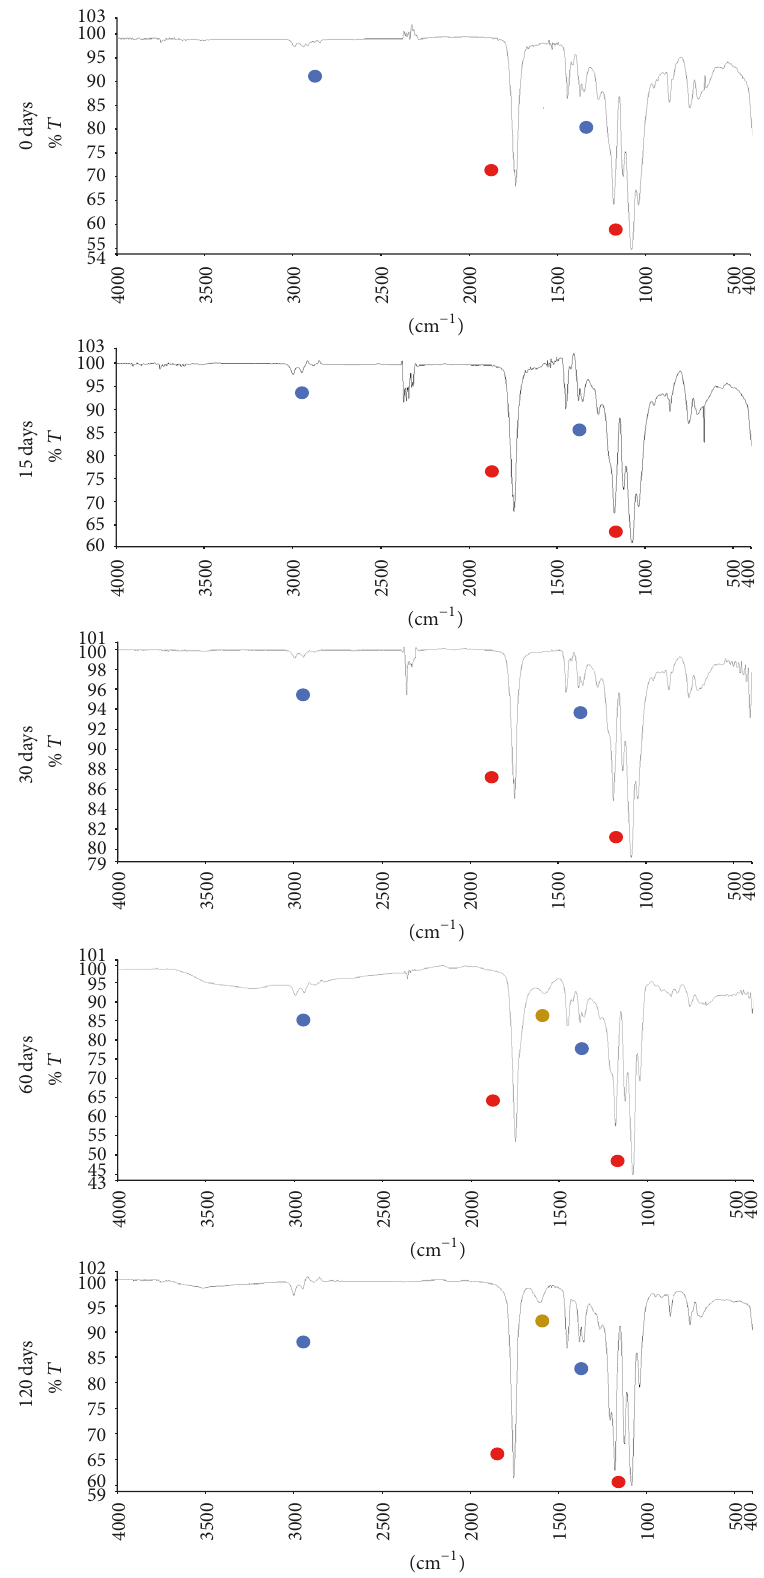
Figure 4: Spectrum related to degradation points 0 to 4 of PLGA plates for the period of 0, 15, 30, 60, and 120 days, respectively. Ester groups = red: 1760–1745 cm −1 and 1300–1150cm −1 ; alkanes groups = blue: 3000–2800 cm −1 and 1450–1370 cm −1 ; oligomer groups = yellow: 1600–1500 cm −1